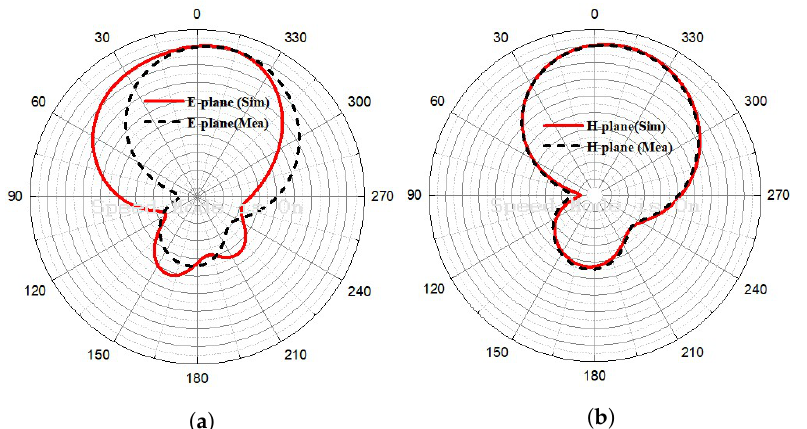
Figure 14. Simulated and measured radiation patterns when port-1 is excited and port-2 is matched.